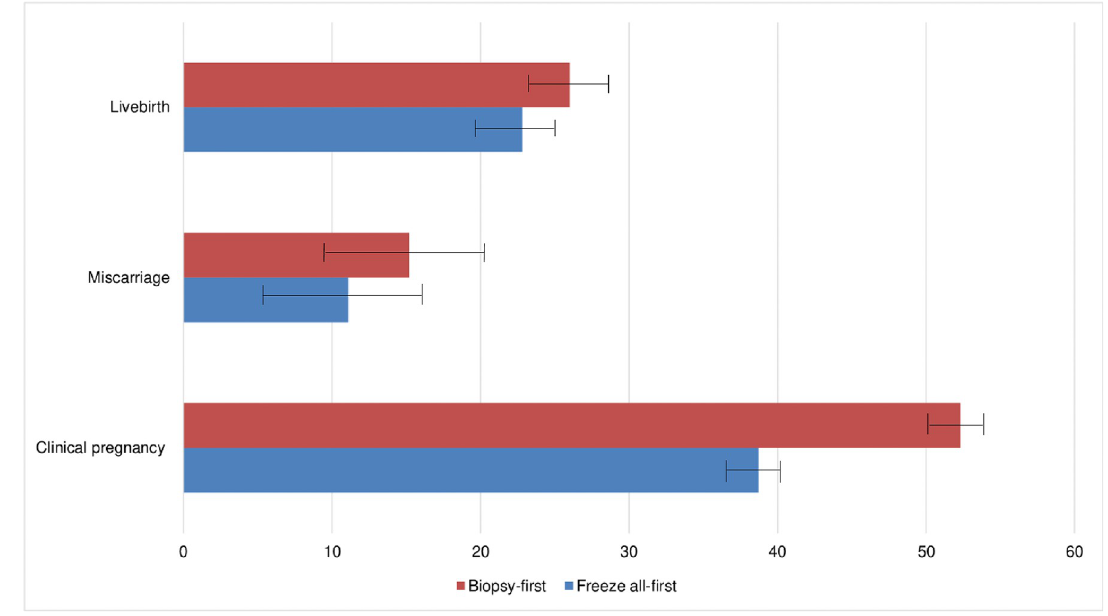
Fig 1. Crude proportions of clinical pregnancy, miscarriage, and live birth in freeze all-first and biopsy-first cycles.